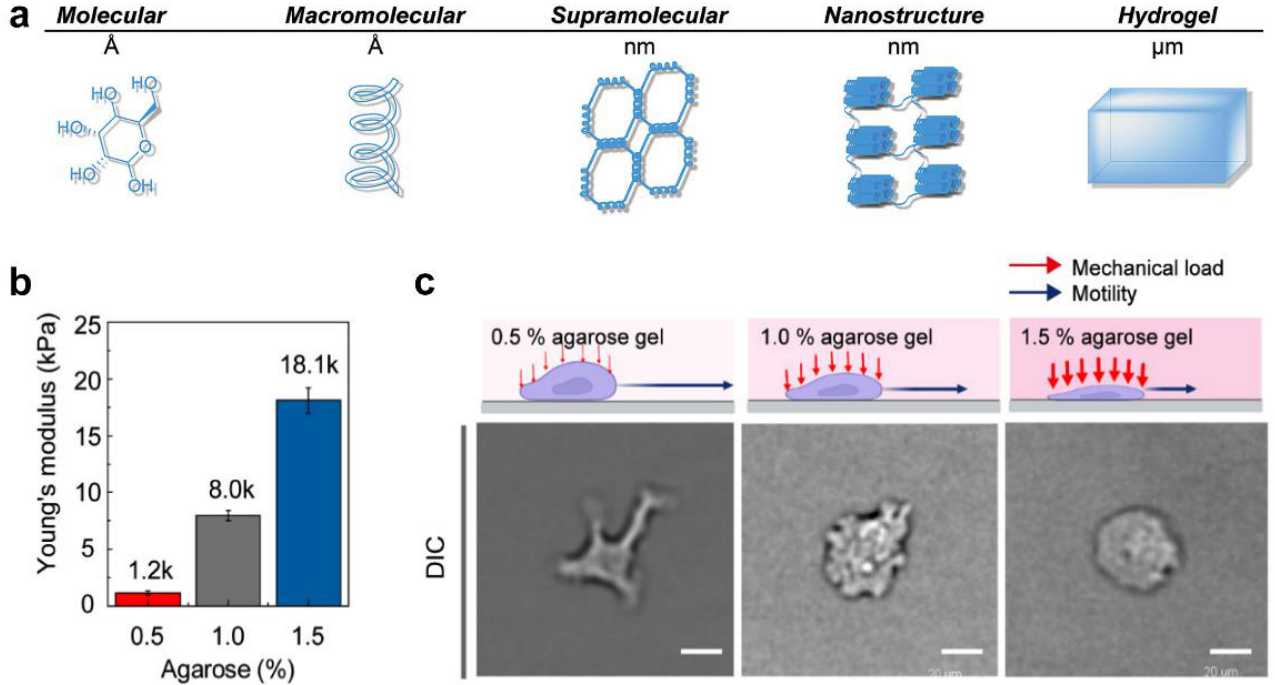
Figure 8. Agarose hydrogel with varied mechanical stiffness for DC culture. ( a ) Agarose hydrogel based on hydrogen-bond interactions. ( b ) The Young’s moduli of agarose hydrogels with different concentrations. ( c ) Agarose hydrogels with various mechanical stiffnesses modulated DCs’ mor- phology. (Reprinted/adapted with permission from Ref. [63], 2021, Yoon-Kyoung Cho et al.).